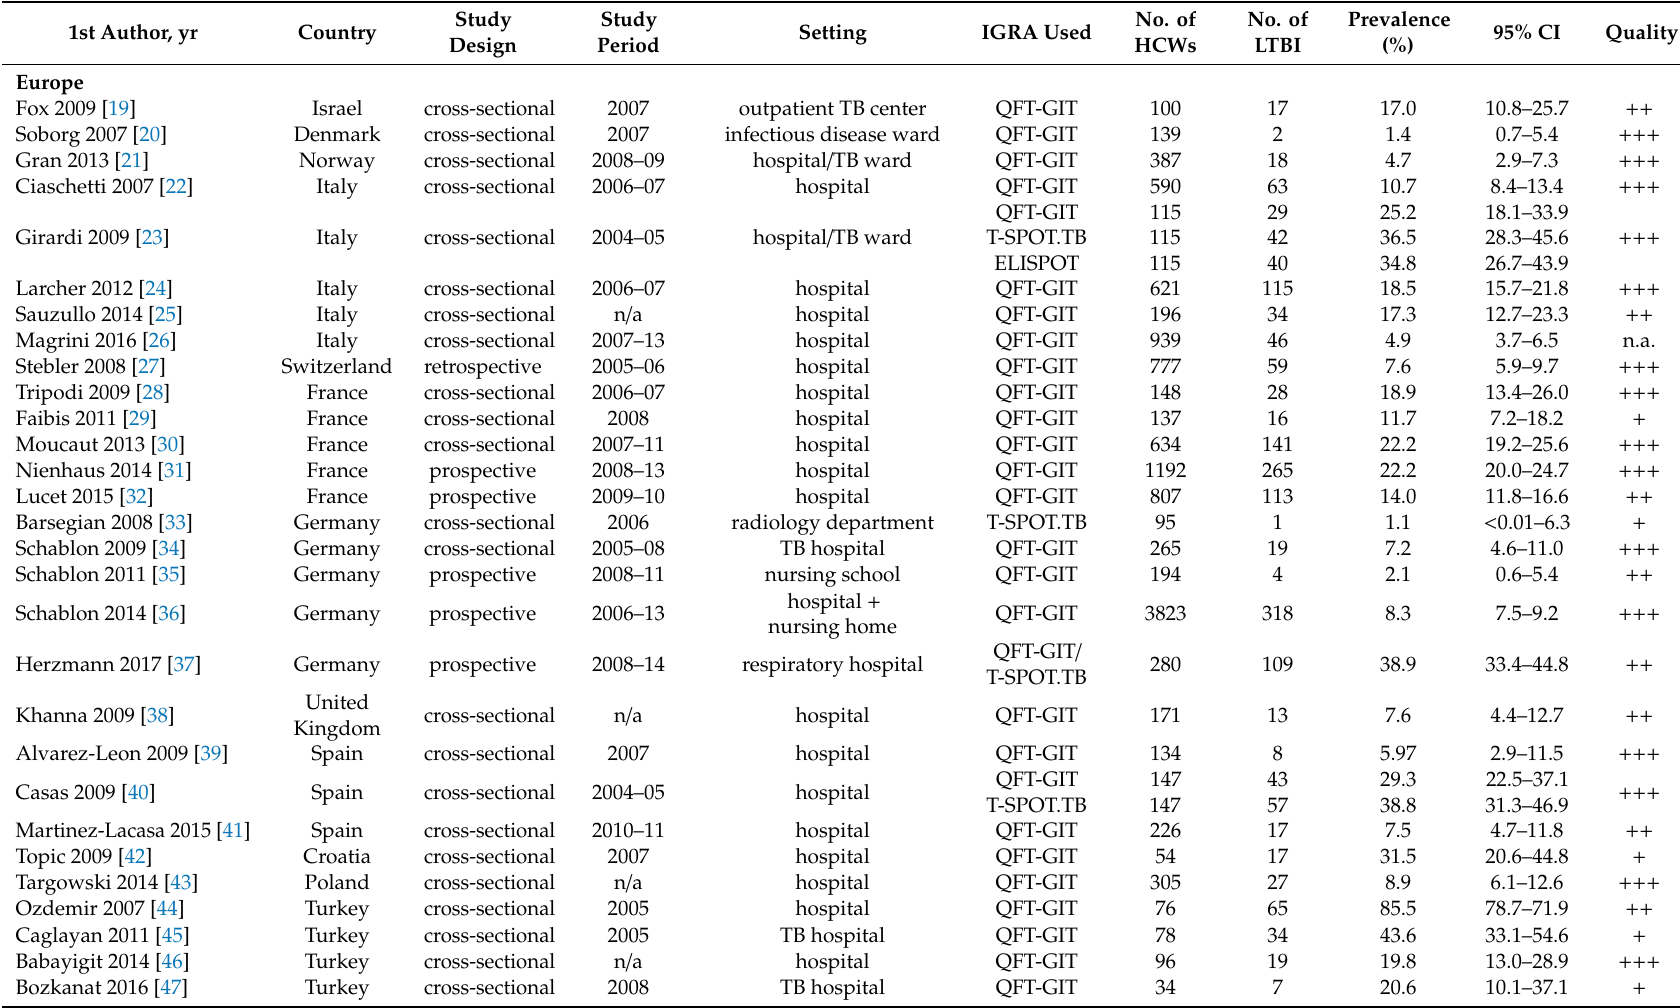
Table 1. Studies of occupational latent tuberculosis infection (LTBI) with interferon- γ release assays (IGRAs) by WHO